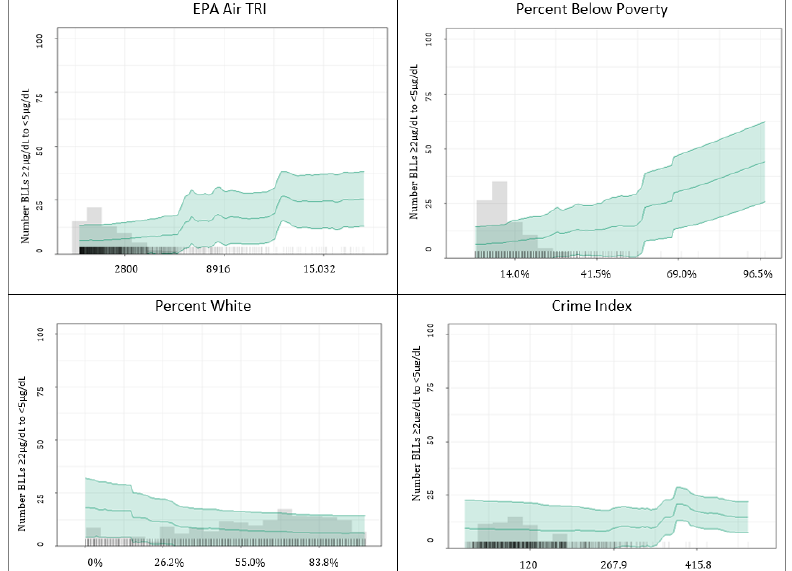
Figure 3. Partial dependence plots for top four ensemble predictors of the number of children in a raster cell with BLLs ≥2– <5 µg/dL.